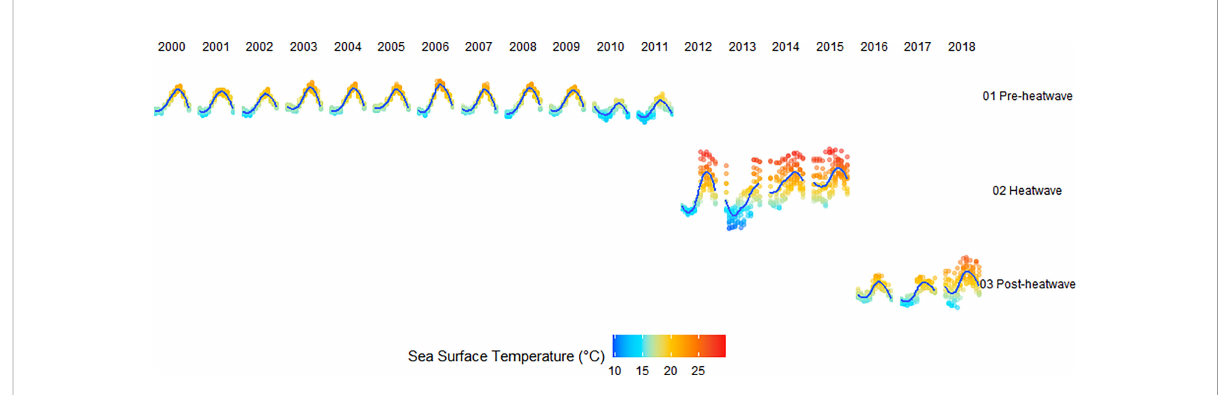
FIGURE 2 Monthly time series of sea surface temperature for all sites. The thermal periods and conditions analyzed are indicated. Red tones represent above-average SST sites; blue tones represent below-average SST sites. The average SST is shown as a blue